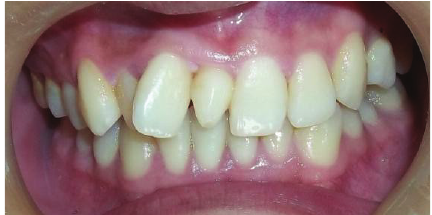
Figure 1: Intraoral photograph showing conical mesiodens.